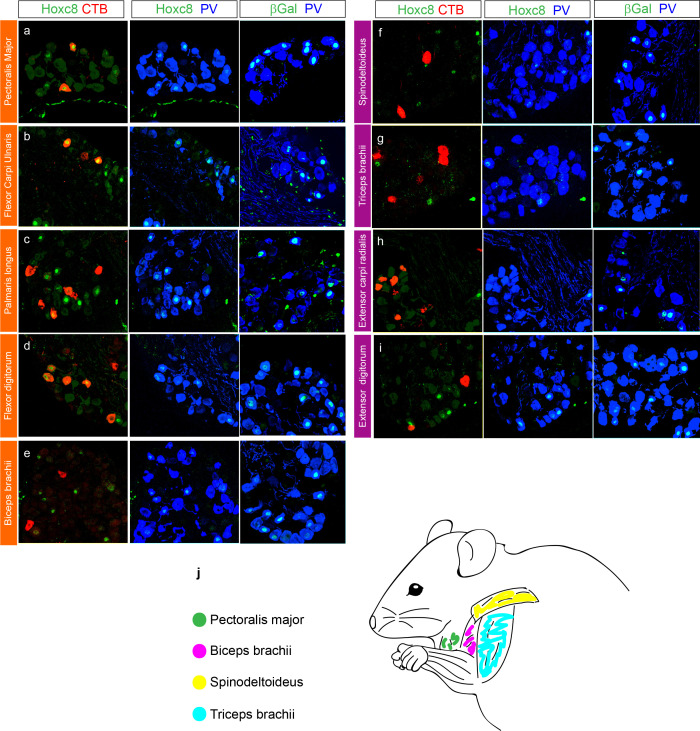
Characterization of Hoxc8+ pSN innervation of forelimb muscles.(a–i) Cross sections of cervical level DRG in PLAT::Cre; Hoxc8LacZ-flox/+ mice injected with CTB in individual limb muscles (N ≥ 3). First column shows colocalization of Hoxc8 and CTB, 2nd column shows colocalization of the same sections in the 1st column with Hoxc8 and PV labeling and 3rd column βGal and PV (see also Figure 4) for CTB injected flexors: PM (a), FCU (b), PL (c), FD (d), Bic (e), and extensors: SD (f), Tri (g), ECR (h), ED (iI). (j) Schematic of injected proximal forelimb muscles: PM, Bic, SD, Tri.